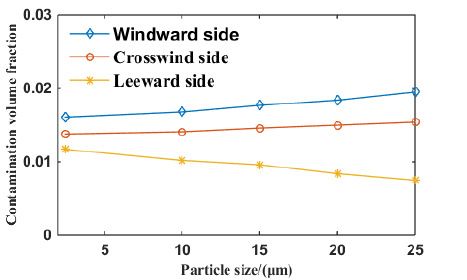
Figure 27. Contamination volume fraction of 2# insulator under different particle